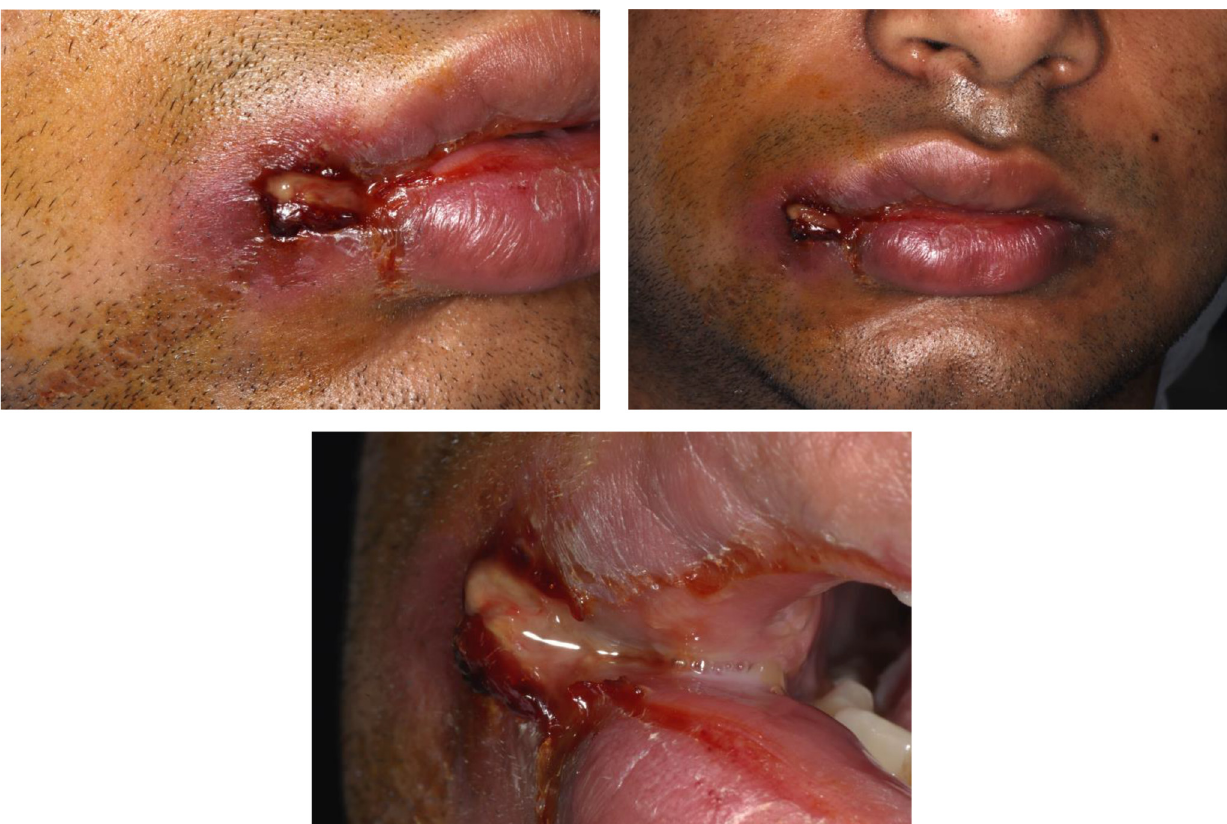
Figs. 1 – 3. Extraoral photograph showing a collected abcess of 20mm of axis located on the labial commissure. The epithelial collarette surrounding the abscess is characteristic. Perilesional scratch and linear mark on the skin provides évidences of